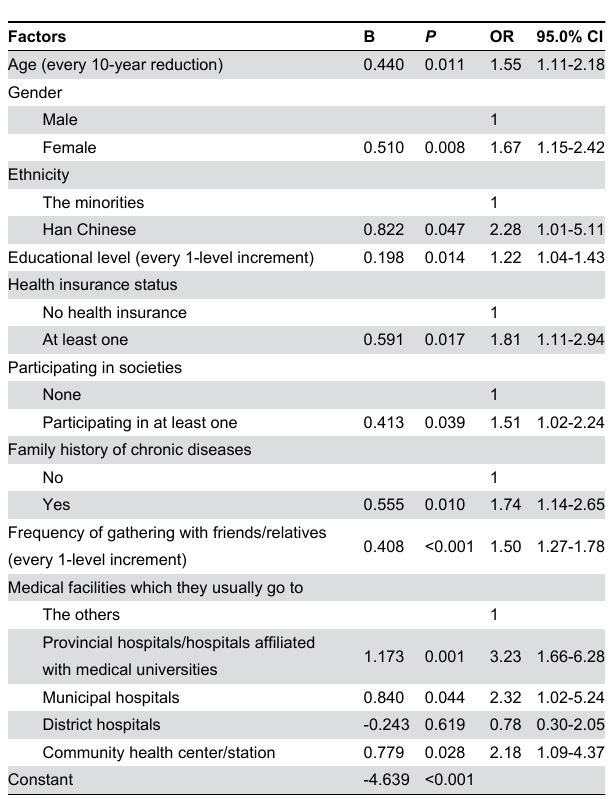
Table 5. Multivariate logistic regression analysis on related factors of higher knowledge among the elderly in